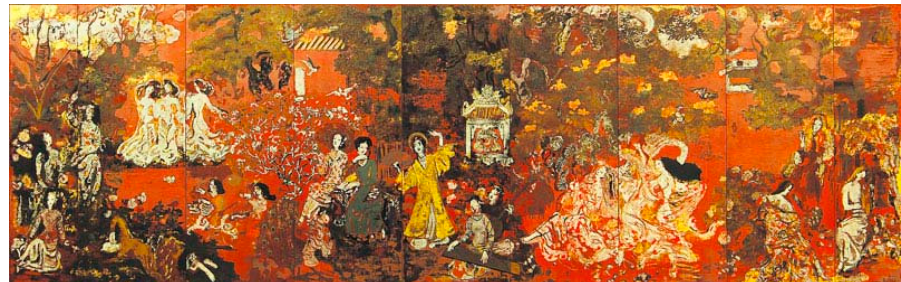
Figure A23. Vuon xuan Bac Trung Nam (The Bac Trung Nam garden in spring)—Nguyen Gia Tri. Where the expert suspected the auctioned Trong vuon copied from. The image was sourced from website soi.today (Long 2015).